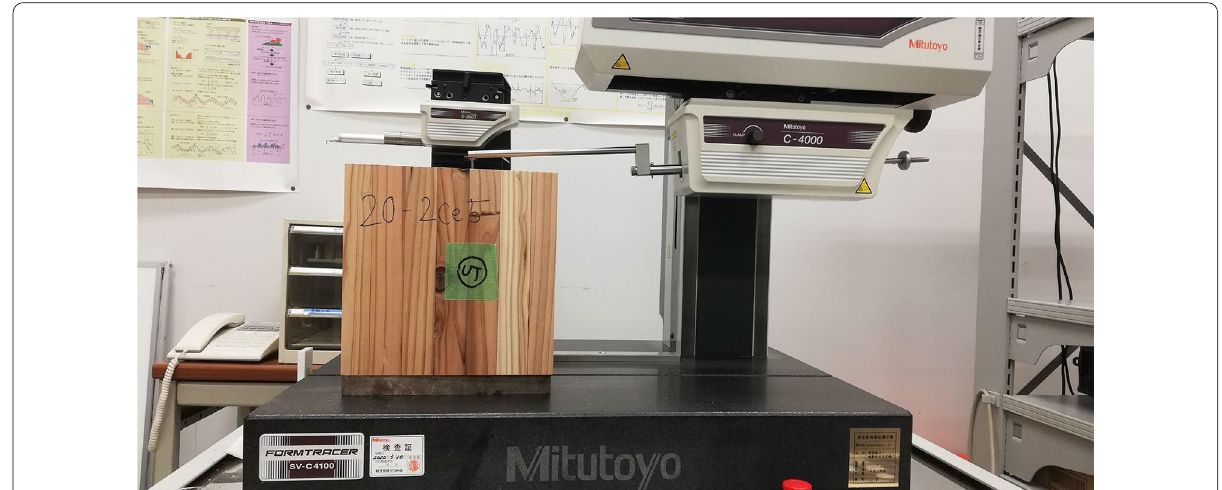
Fig. 4 Surface measurement of cedar and cypress